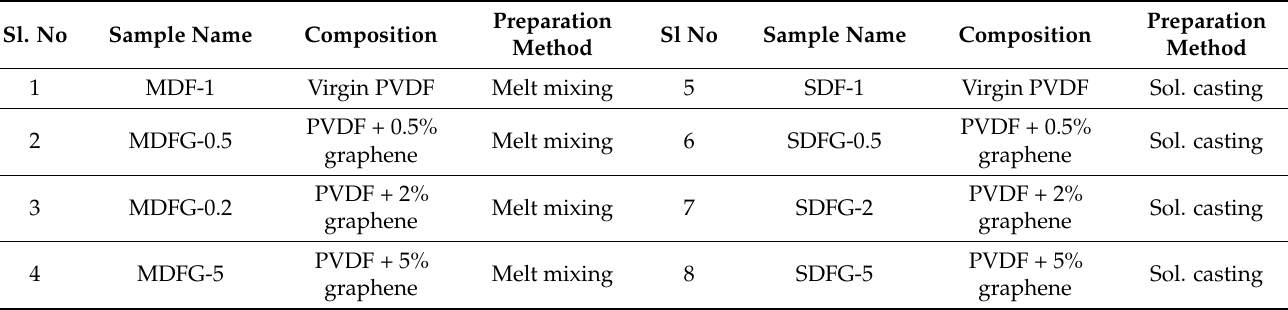
Table 1. Nomenclature of the Prepared